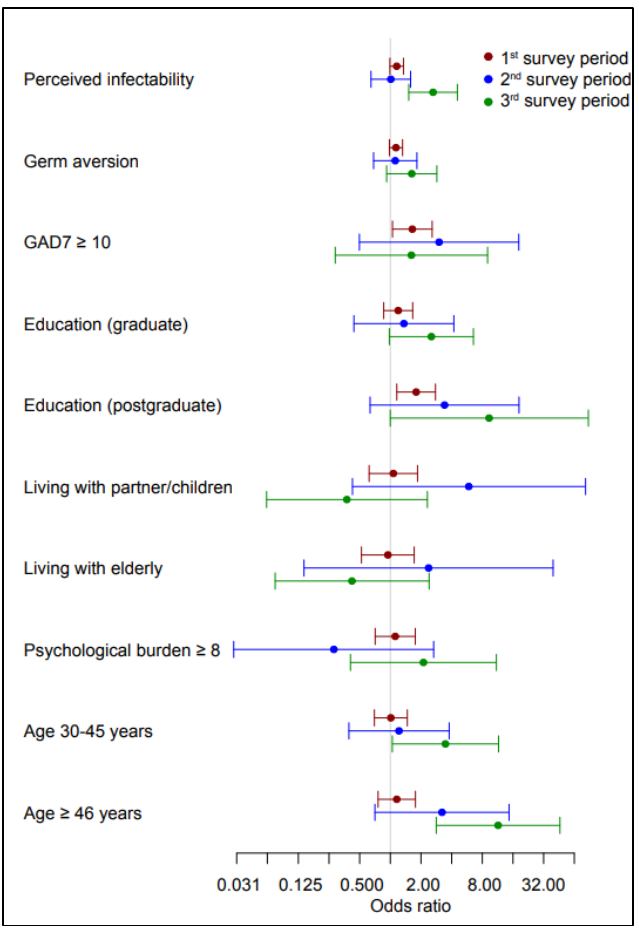
Figure 1. Regression analysis of factors influencing vaccination intention in the survey periods. Odds ratios above 1 denote greater intention to be vaccinated.